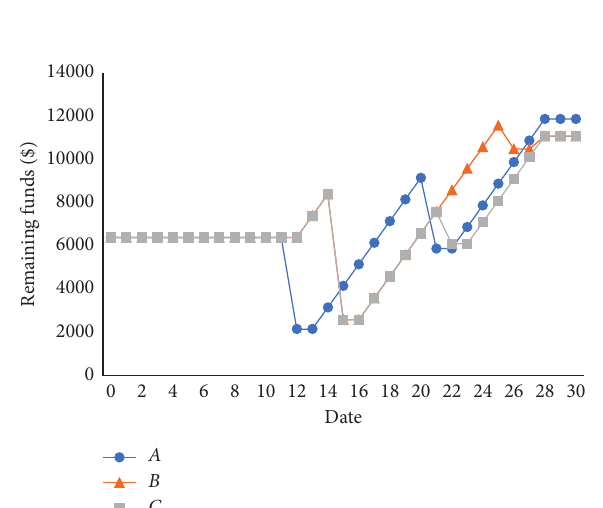
Figure 17: Comparison of remaining food.